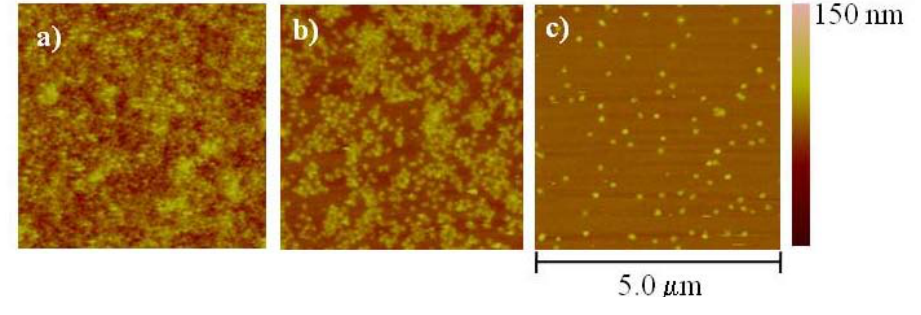
Figure 5. Atomic force microscopy (AFM) topographical images of T4 nanoparticles deposited on aminosilanized glass with a) no dilution, b) 1:1 dilution in 10 mM Tris-HCl at pH 8.8 and c) 1:50 dilution in 10 mM Tris-HCl at pH